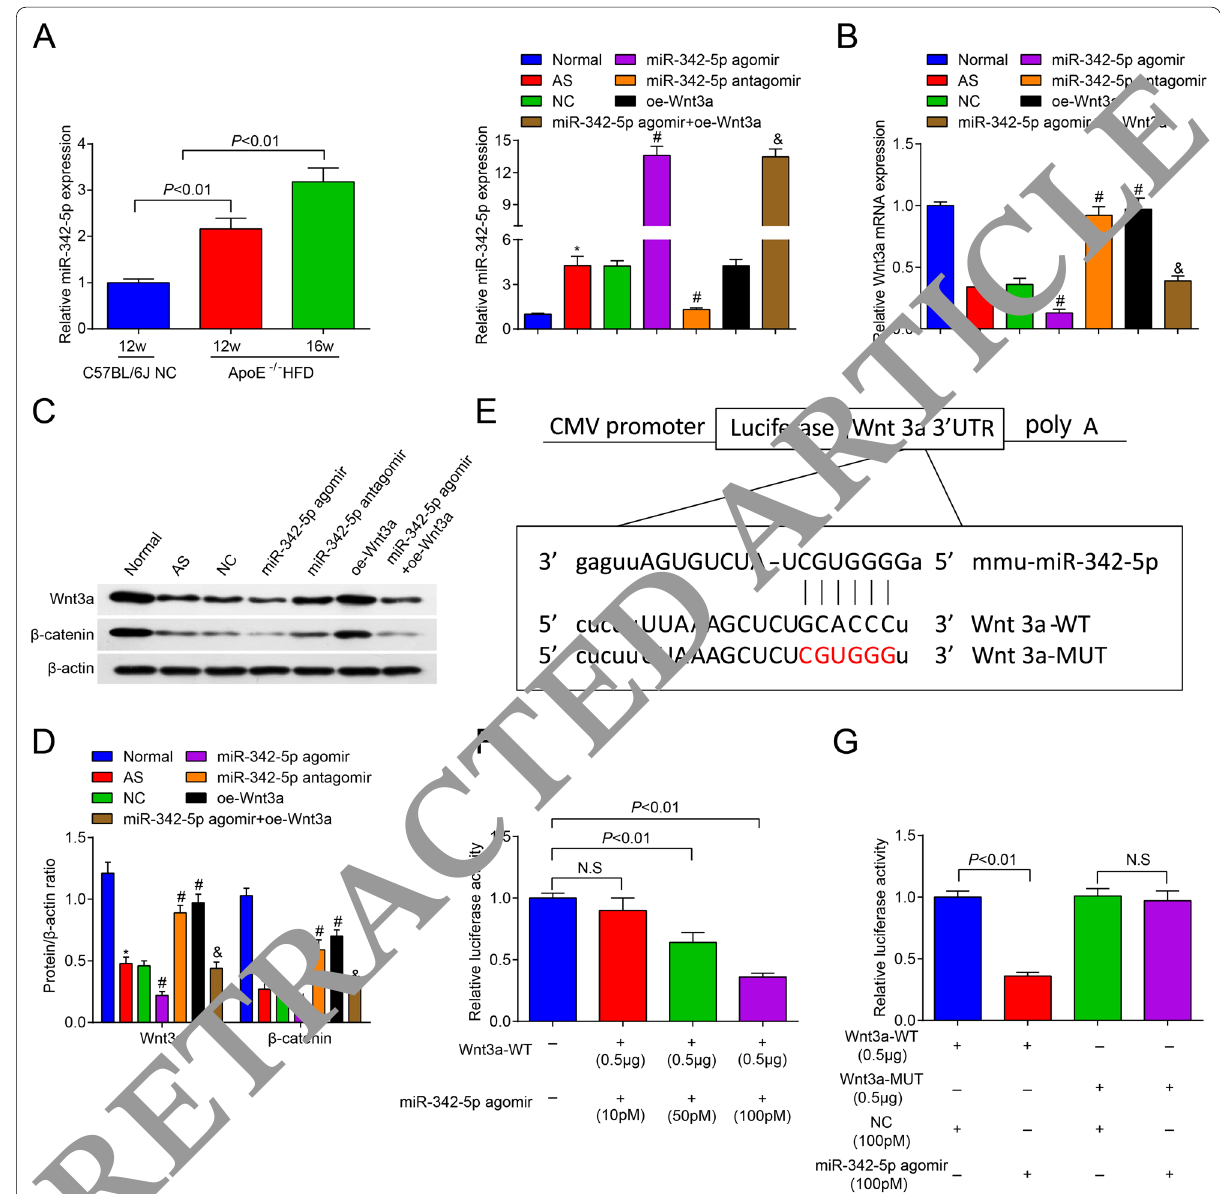
Fig. 1 miR-342-5p increases and Wnt3a decreases in aortic tissues of ApoE − / − mice and miR-342-5p directly targets Wnt3a. A Expression of miR-342-5p in aortic tissue of mice detected by RT-qPCR. B Expression of Wnt3a mRNA in aortic tissue of mice detected by RT-qPCR ( n Wnt3a and β-catenin protein expression in aortic tissues of mice tested by Western blot analysis ( n 3 ′ -UTR. F miR-342-5p agomir dose-dependently decreased the relative activity in cells transfected with Wnt3a 3 ′ -UTR ( N luciferase in cells with wild-type and mutant Wnt3a 3 ′ -UTR after transfected with miR-342-5p agomir or scramble ( N group, # P < 0.05 vs. the NC group. & P < 0.05 vs. the miR-342-5p agomir group. Measurement data were indicated as mean Comparisons between two groups were formulated by t -test, while comparisons among multiple groups were assessed by one-way ANOVA followed by Tukey’s multiple comparisons test. AS, atherosclerosis; NC, negative control